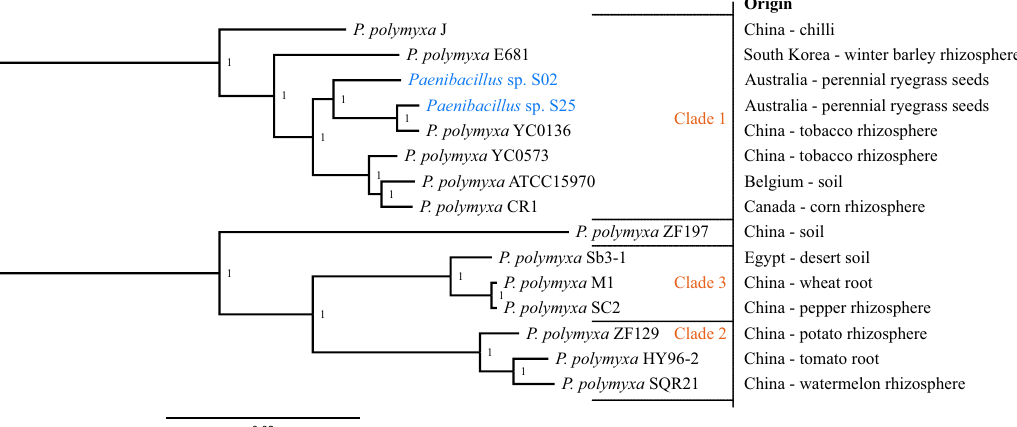
Figure 2. Phylogeny of Paenibacillus species based on a pan genome Roary analysis of strains S02 and S25 and 13 P. polymyxa strains with complete circular genome sequences. The maximum-likelihood tree was inferred based on 2059 genes conserved among 15 genomes. Values shown next to branches were the local support values calculated using 1,000 resamples with the Shimodaira-Hasegawa test. Paenibacillus sp. strains S02 and S25 clustered with other six P. polymyxa strains in Clade 1. Clades 2 and 3 separated from Clade 1 at the root node, and consisted of three P. polymyxa strains